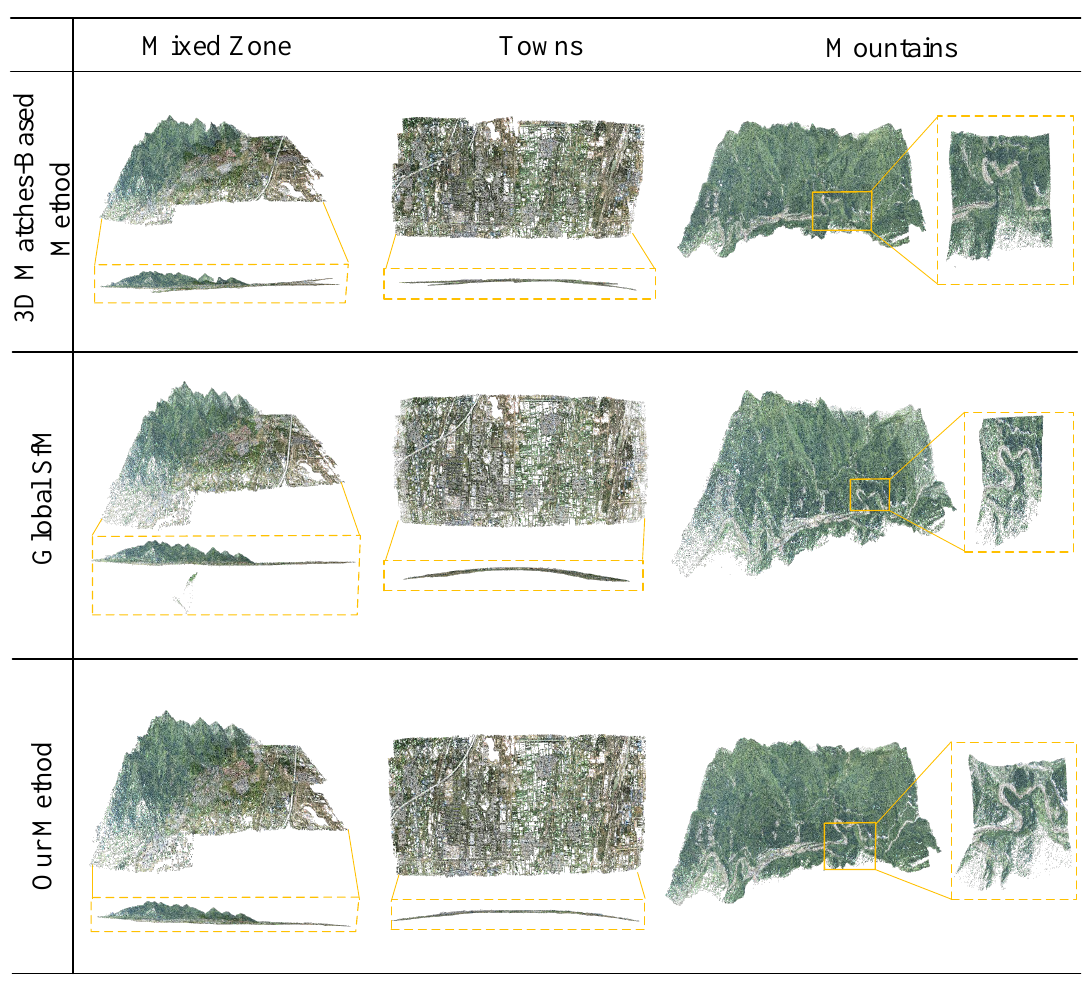
Figure 9. Experimental comparison results on three datasets, from left to right: mixed zone, towns, and mountains. From top to bottom, the results of the 3D point matching-based method, the reconstruction results of the global Structure from Motion (SfM) [12], and the reconstruction results of our method. Additionally, the visual differences between the reconstruction results are shown in the rectangular